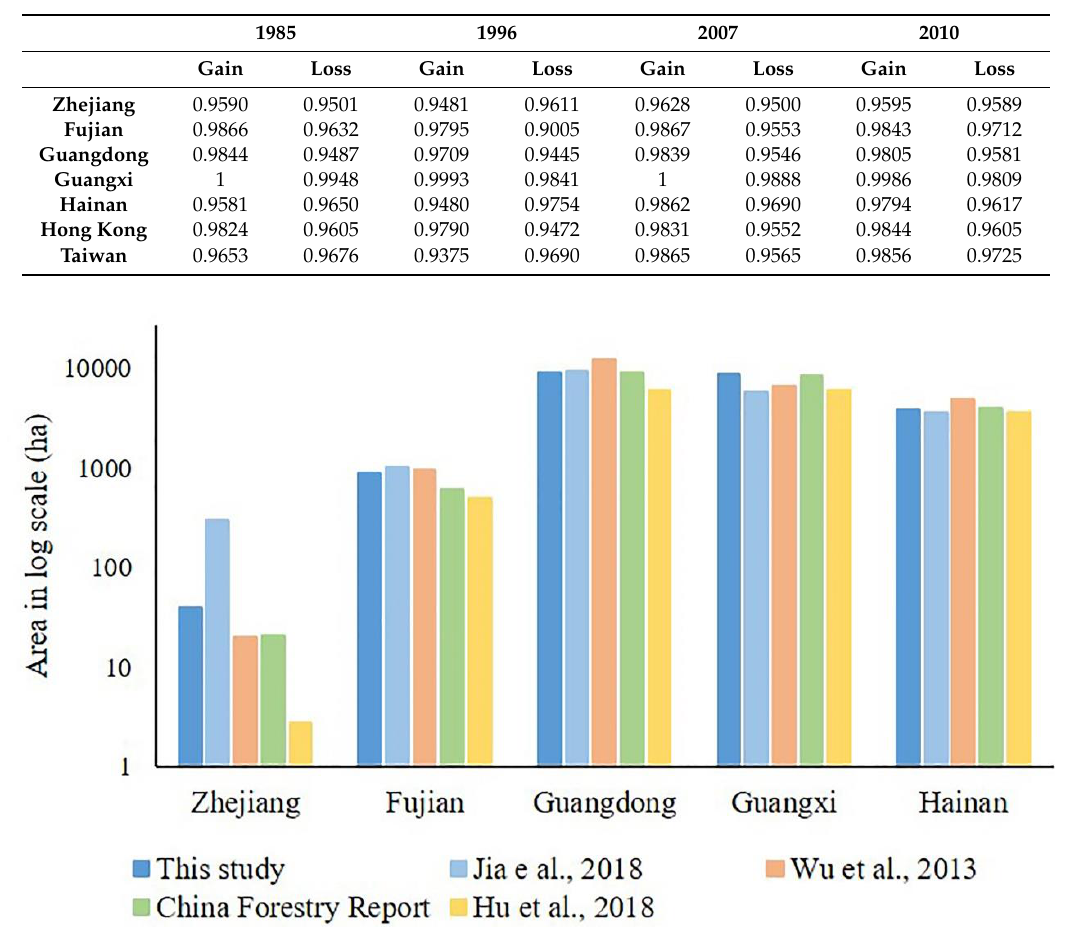
Figure A1. Mangrove areas’ comparison with other available data in 2010.